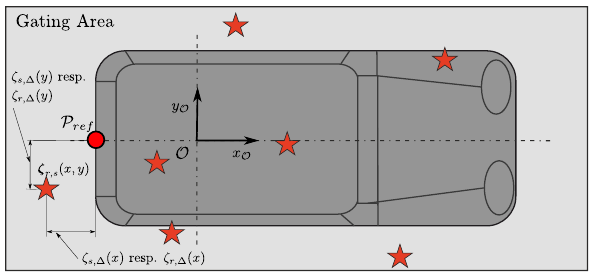
Figure 6. Reference point P ref ( x , y ) on the dynamic object; Deviation target points real sensor to reference point ζ r , ∆ ( x , y ) and deviation target points simulation to reference point ζ s , ∆ ( x , y ) according to